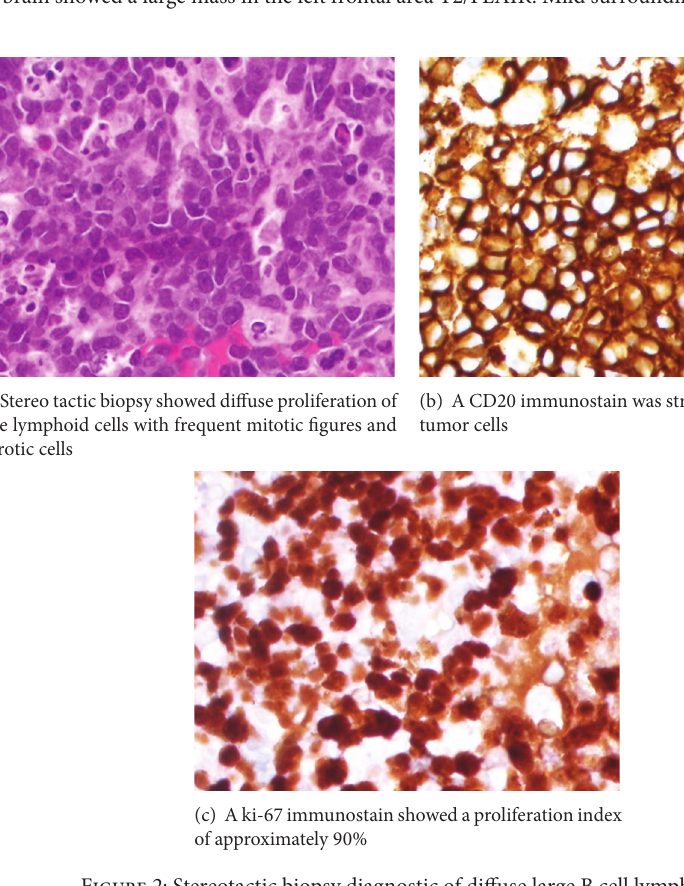
Figure 2: Stereotactic biopsy diagnostic of diffuse large B cell